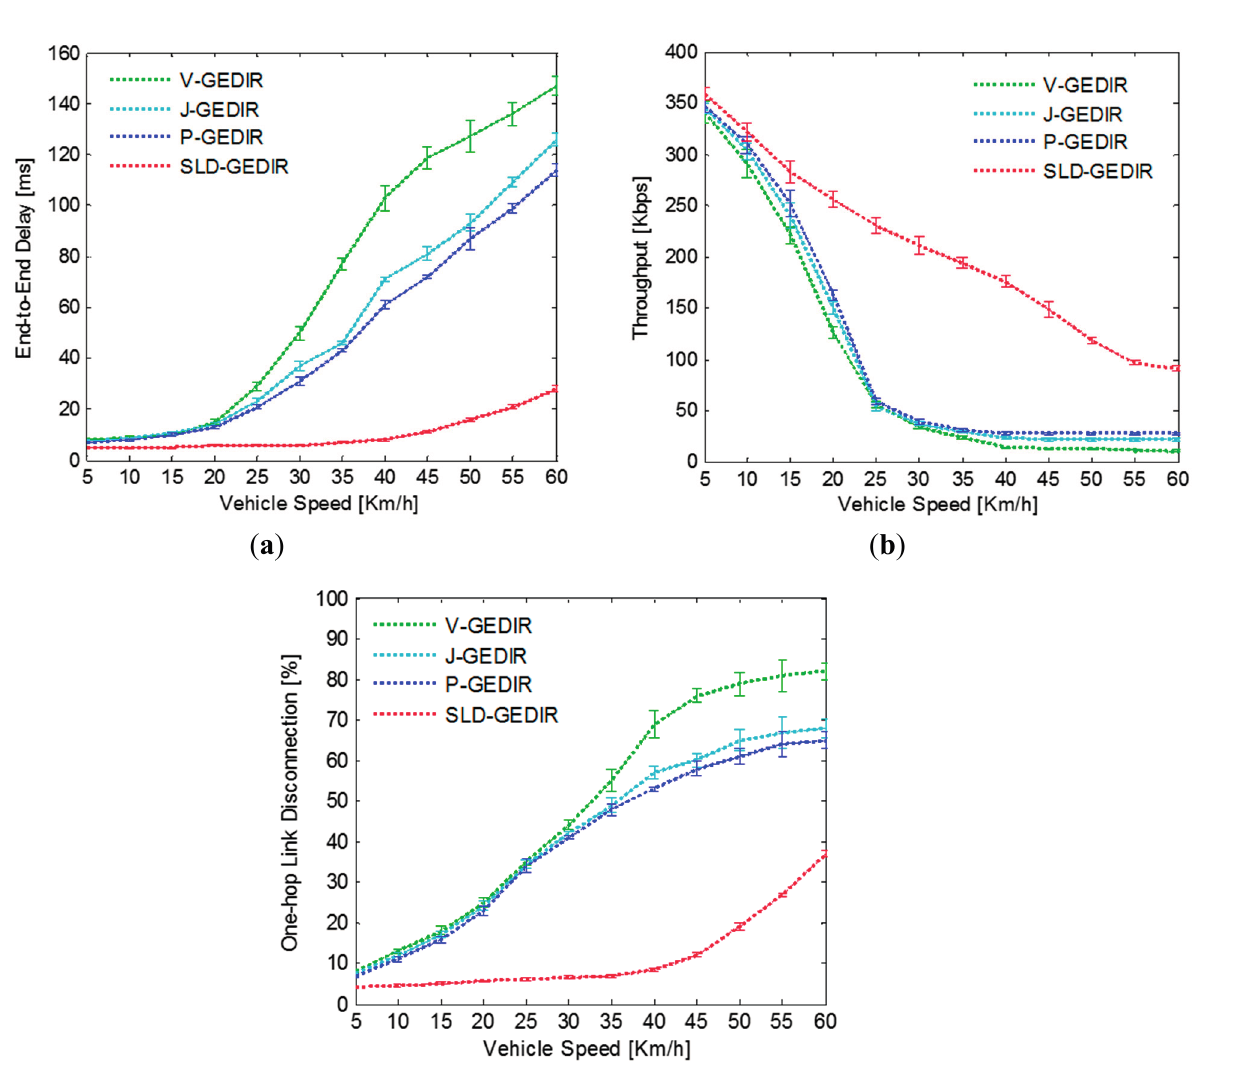
Figure 10. Impact of speed in ( a ) end-to-end delay; ( b ) throughput and ( c ) one-hop link